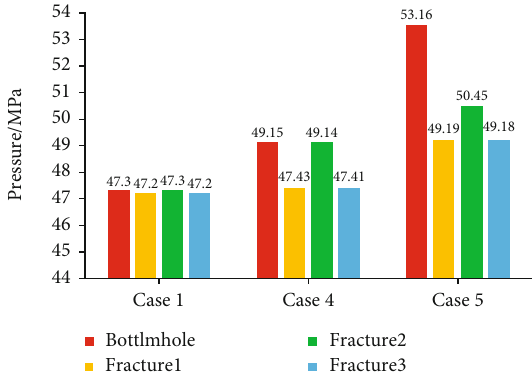
Figure 17: Bottomhole pressure and pressure at various fracture mouths when fracturing for 50s for three di ff erent perforation design parameters.